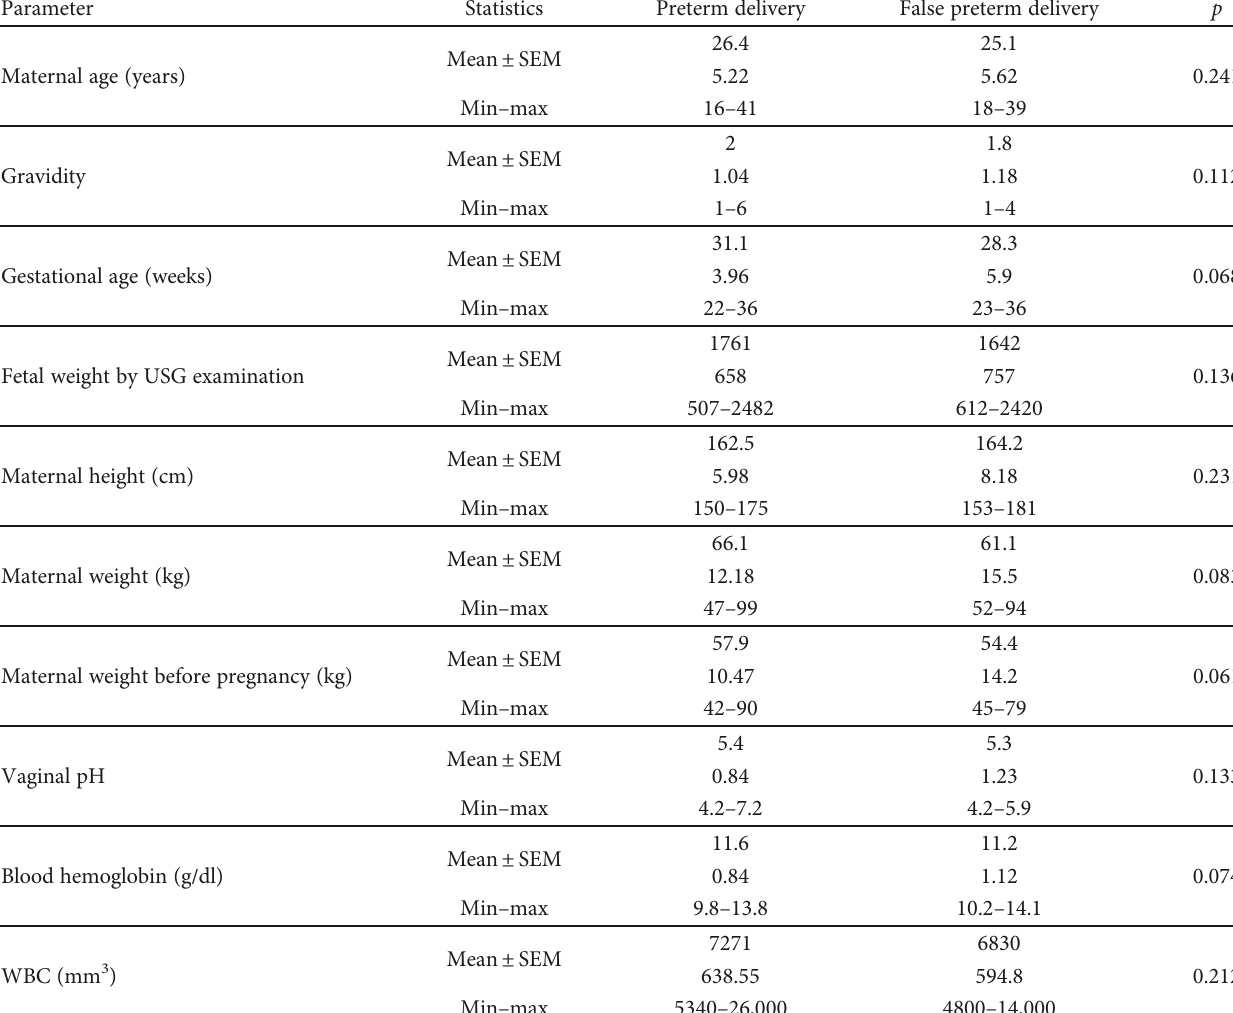
Table 1: Characteristic of the